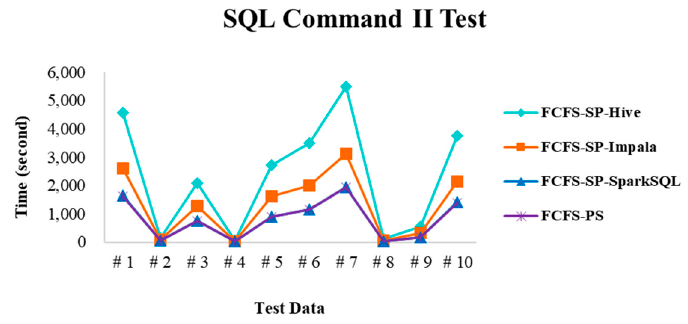
Figure 27. Execution time of SQL command III in test environment III.